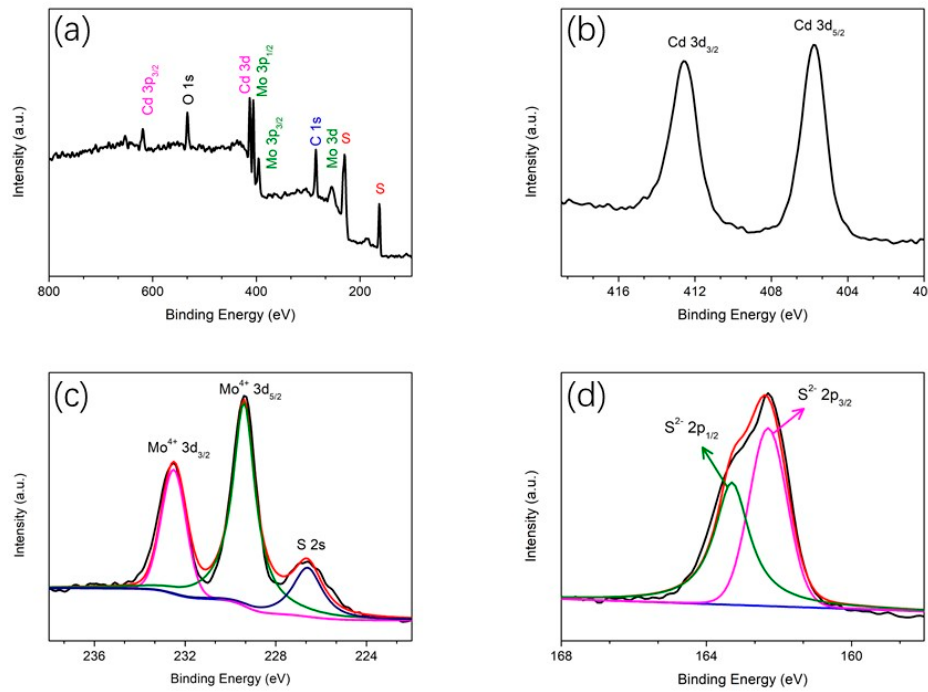
Figure 4. X-ray photoelectron spectroscopy (XPS) spectra of MC15: ( a ) survey spectra; ( b ) Cd 3d spectra; ( c ) Mo 3d and S 2s spectra; ( d ) S 2p spectra.